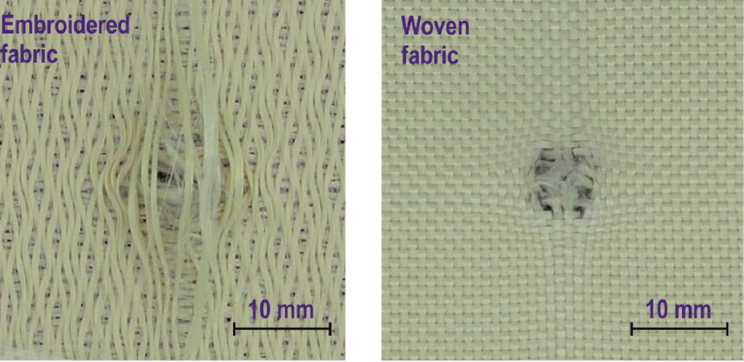
Figure 6. Photos of the embroidered and woven structure after the bullet was pierced. Embroidered structures, therefore, have two advantages and one disadvantage in terms of ballistic shock response. The advantages are straightened threads and the lack of interlacing, which is conducive to a high speed of propagation, which has a positive effect on a lower transverse deformation of the packet. The disadvantage of these structures is the sliding of the threads in contact with the front of the bullet, which adversely affects the number of shot layers in the ballistic package. It should be noted that the intensity of thread spreading depends on the angle of the conical surface pressing against the embroi- dered structure. In the case of a multilayer ballistic package, the spreading of threads in the subsequent layers will be smaller and it will not occur at all in the final layers. Woven structures have advantages and disadvantages in their response to ballistic impact, which are in contrast to the advantages and disadvantages of embroidered structures. The ad- vantage here is the structure that is jammed by the weft and warp threads, which prevents the threads from sliding apart in contact with the front of the bullet. In turn, the disad- vantages of this structure are the weft and warp threads and the lower speed of stress wave propagation due to the interwoven structure, which favors increased transverse de- formation. Considering the advantages and disadvantages of both structures, it seems reasonable to create a multi-layer hybrid pack that will include structures woven on the front and embroidered on the back. Figure 4 shows the deformation of the plasticine base for the ballistic package (Variant IV) made in this way, which includes 13 layers woven on the front and 13 layers embroidered on the back. It is clearly visible that the maximum deformation depth is even smaller than for the package consisting of 26 embroidered lay- ers (Variant I), and it was 22.6 mm. On the other hand, a very unfavorable variant, high- lighting the disadvantages of woven and embroidered structures, would be the construc- tion of a multi-layer hybrid package containing structures embroidered on the front and woven structures on the back. Figure 4 shows the deformation of the plasticine base for the package made in Variant III, with 13 embroidered layers on the front and 13 woven layers on the back. The maximum deformation of the substrate was even greater than in the case of firing a package consisting of only fabrics (Variant V) and amounted to 34.1 mm. The response of the hybrid packages made in Variants IV and III confirms the exist- ence of advantages and disadvantages of embroidered and woven structures, but their proper management allows to significantly improve the ballistic properties of the pack- ages. During the research, a hybrid package consisting of woven and embroidered struc- tures arranged alternately (Variant II) was also subjected to fire. Figure 4 shows the defor- mation of the plasticine base for the package made in this variant. The maximum value of deformation was 23.9 mm and was 1.4 mm higher than in Variant IV, for which the lowest value of this deformation was obtained. The arrangement of alternating layers seems to be advantageous on the one hand because the package is stable when fired by a larger number of bullets; on the other hand, it is possible to make structures embroidered di- rectly on the para-aramid fabric without the substrate. Then, the effect of increasing the